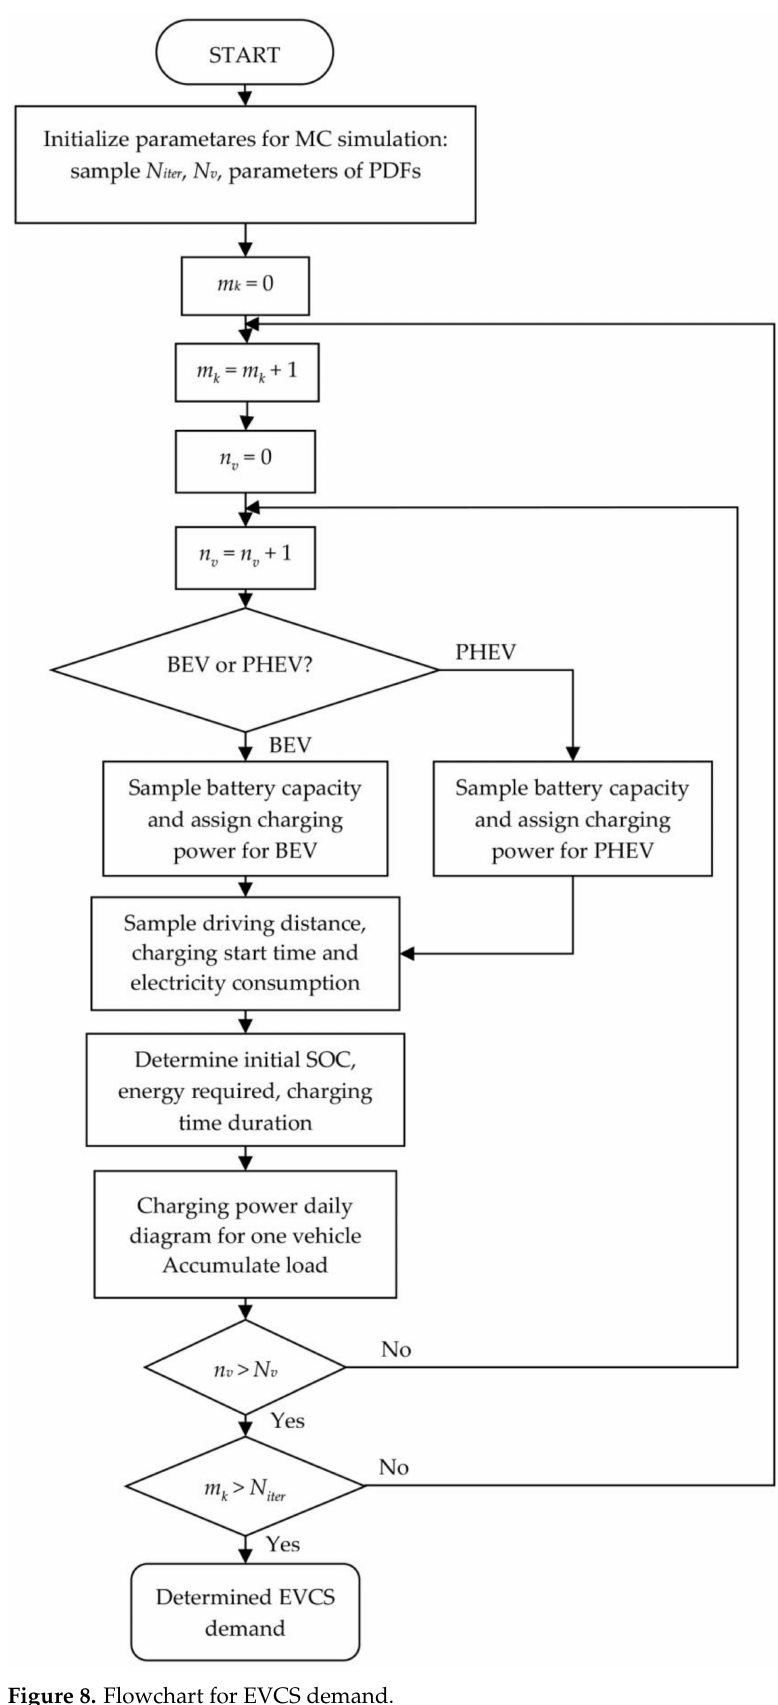
Figure 8. Flowchart for EVCS